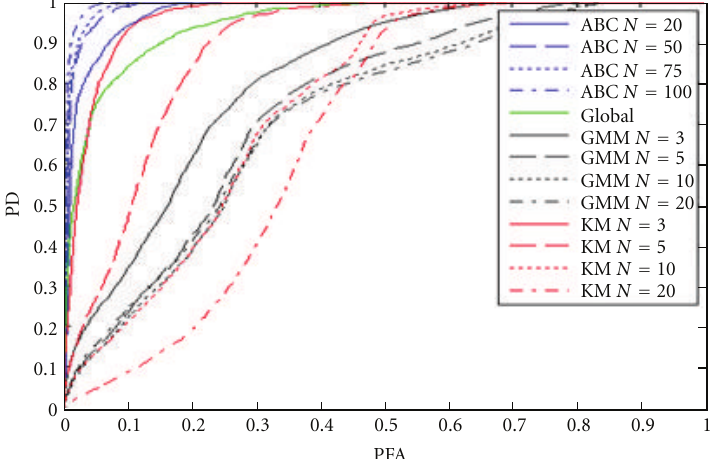
Figure 12: ROC curve performance testing QG-SemiP (ABC), global RX (Global), k means (KM), and GMM detectors on scene shown in Figure